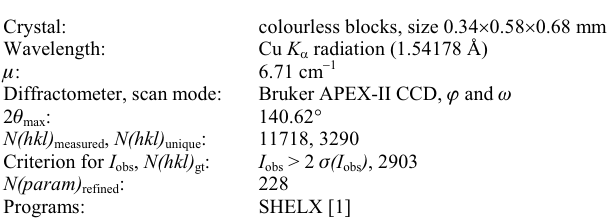
Table 1. Data collection and handling.